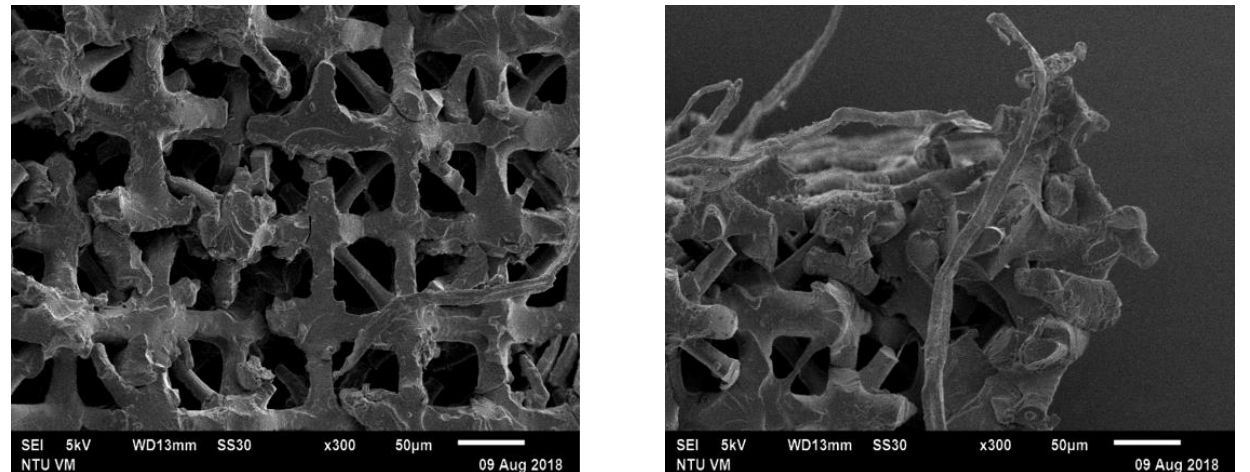
Figure 11. Fracture surface appearance of the 130 µ m micro-lattice structure after compressive failure.